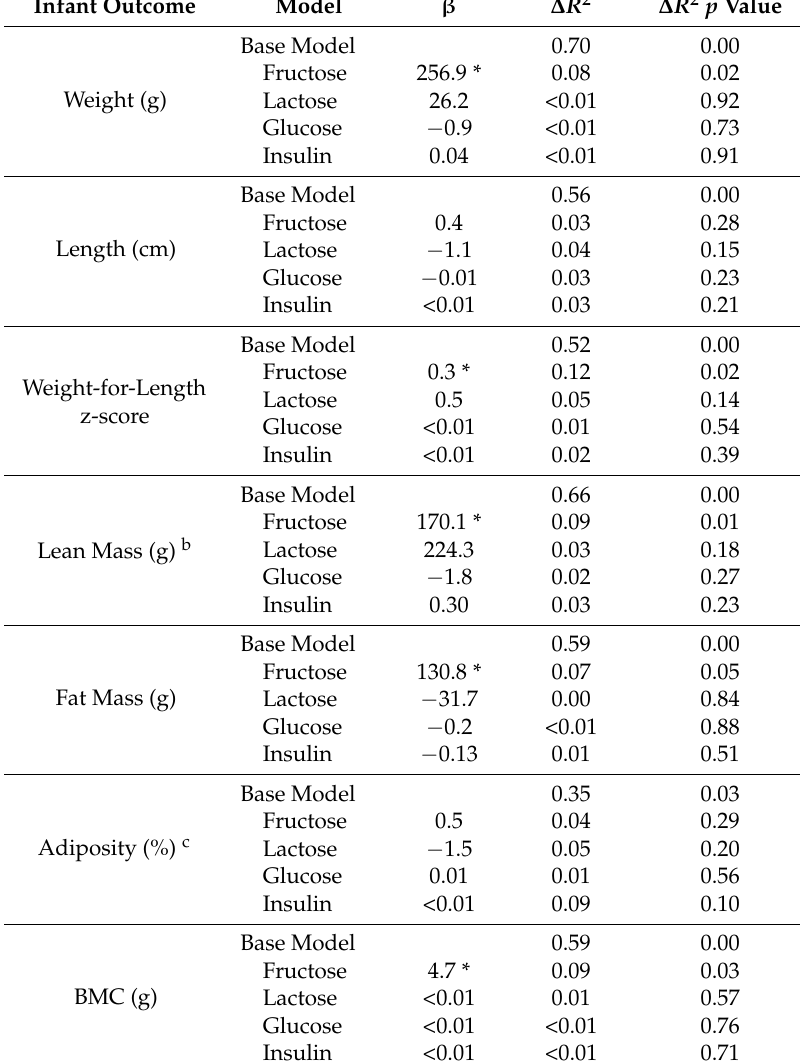
Table 3. Relationships between breast milk sugars and infant body composition at 6 months of age a . Infant Outcome